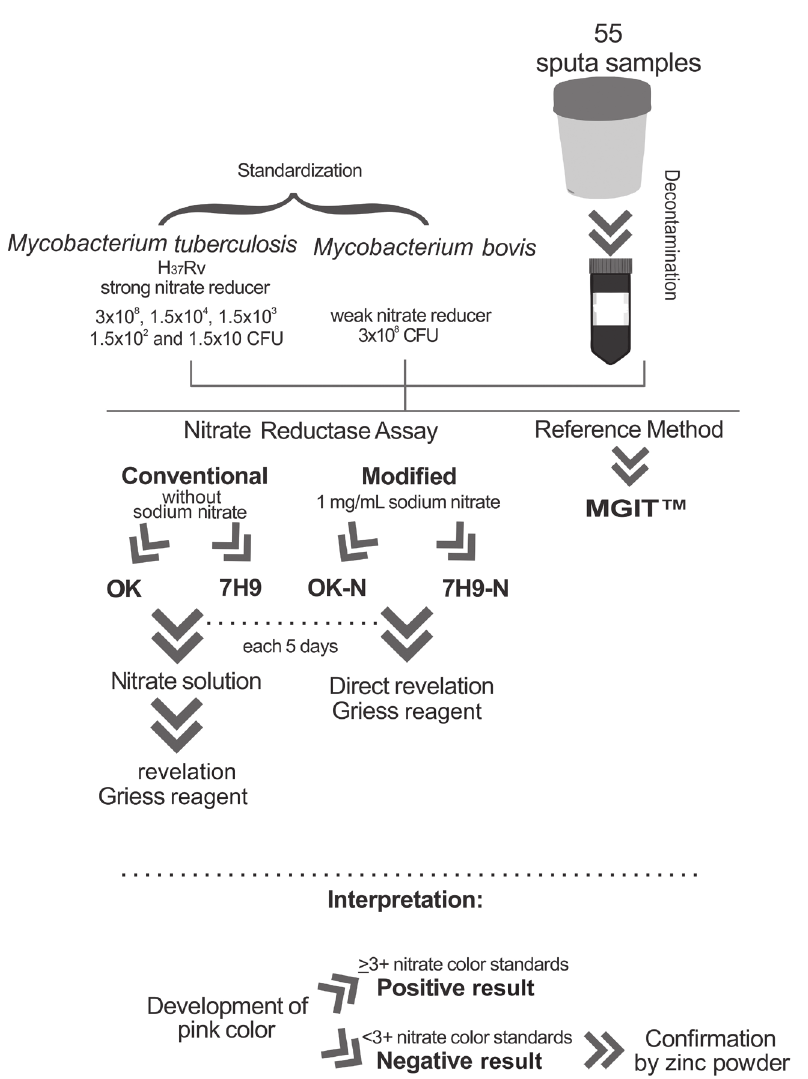
FIGURE 1 - Schematic representation of the procedure used for the standardization of Nitrate Reductase Assay. Limit of detection of assays and weak nitrate reduction pattern were determined by serial dilutions of Mycobacterium tuberculosis H Mycobacterium bovis AN5 strains, respectively. Decontaminated sputa samples and reference strains were inoculated in media with and without nitrate (7H9, 7H9-N, OK, OK-N). The MGIT TM (Mycobacteria Growth Indicator Tube) (Becton Dickinson, USA) was used as a reference method for mycobacterial growth detection. Every five days, an aliquot of 300 µLof 7H9-N media was directly read by adding 225 µL of Griess reagent. In the case of 7H9 cultures, 300 µL were inoculated in nitrate buffer and incubated for 2 hours till nitrite detection. In the case of solid media, a slice of medium was removed and reaction with Griess reagent was directly carried out for OK-N and indirectly in OK by adding the slice of medium in nitrate buffer solution to detect nitrate reduction. Development of a strong pink color indicates bacterial nitrate to nitrite reduction. CFU: colony forming units; OK: Ogawa Kudoh medium OK-N: Ogawa Kudoh medium supplemented with sodium nitrate; 7H9: Middlebrook 7H9; 7H9-N: Middlebrook supplemented with sodium